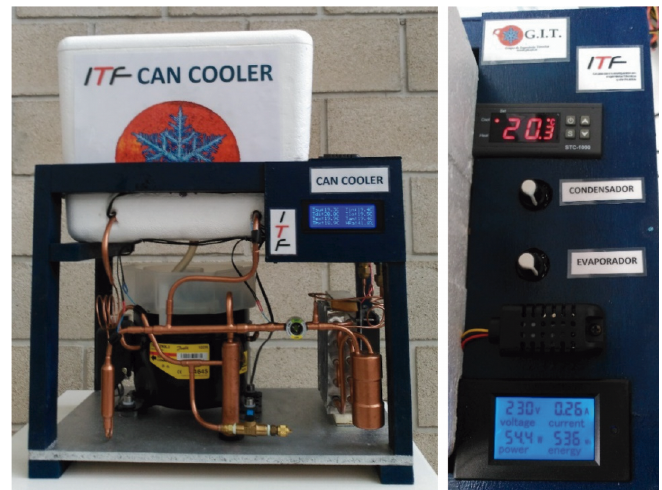
Figure 8. Front (a) and detail of the upper part